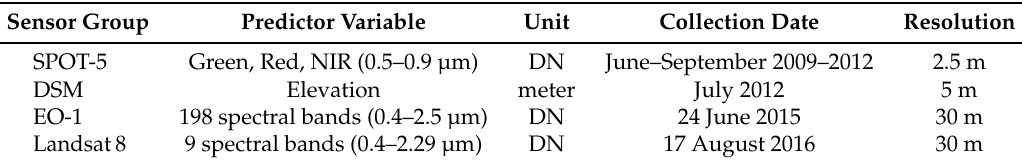
Table 2. Spectral and topographic variables used in the optical- and SAR-derived classifications, where DN stands for Digital